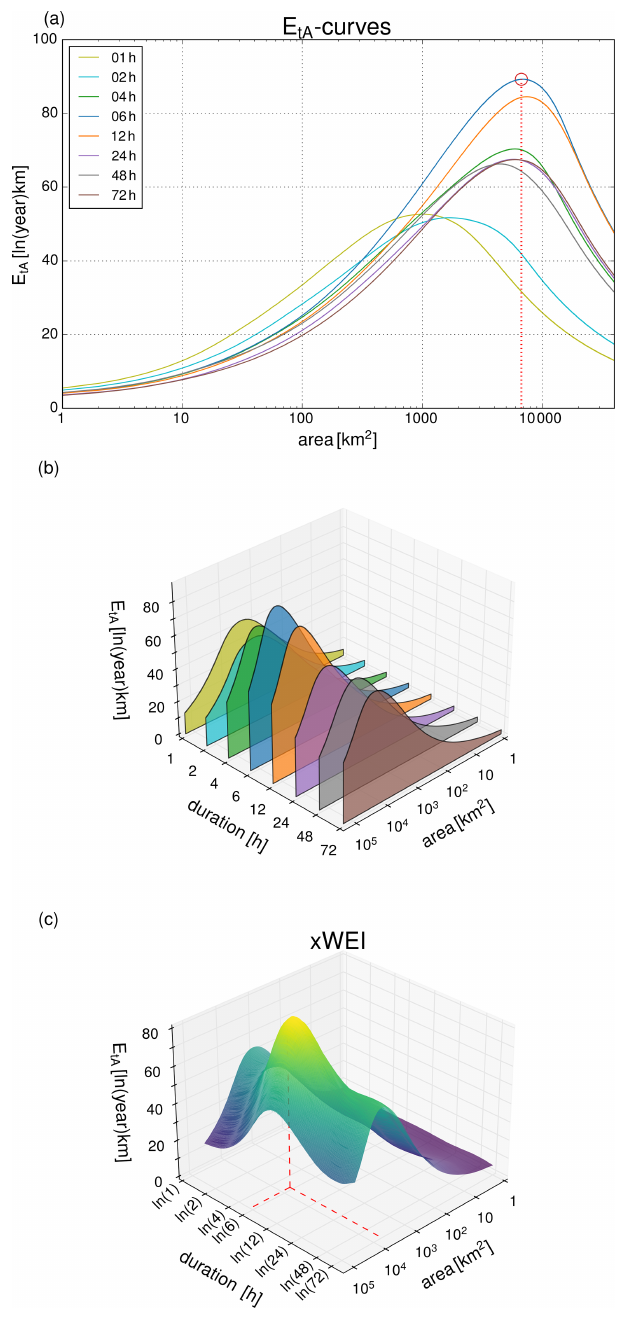
Figure 2. (a) E tA curves for different durations plotted along the spatial dimension (area), with the WEI marked by a red circle. (b) The same E tA curves as in (a) , but aligned along the tempo- ral dimension (duration). (c) E tA values from (b) interpolated on a regular grid of logarithmic values of durations and area. All plots display the same extreme precipitation event